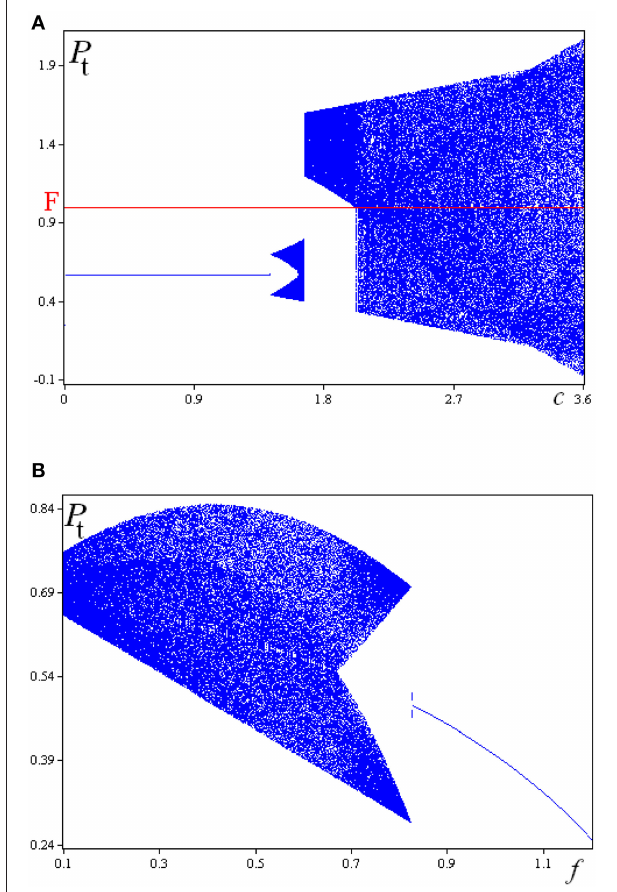
FIGURE 3 | The bifurcation diagram with respect to c (A) is obtained by using a = 1.7, while the bifurcation diagram with respect to f (B) is obtained with a = 2.6. The remaining parameters are the same used in Figure 2